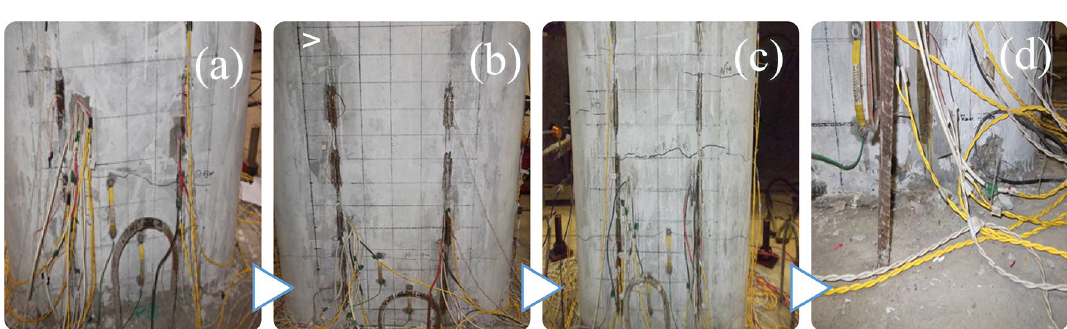
Figure 10. Damage at the bottom of the M-1 model during the experimental program. Height (2.0 m); Aspect ratio 8.0; lxial compression ratio (10%); longitudinal reinforcement rate (0.75%); volumetric volumetric stirrup ratio (0.45%). ( a ) First crack on the north side; ( b ) first crack on the south side; ( c ) final crack on the north side; ( d ) concrete crush